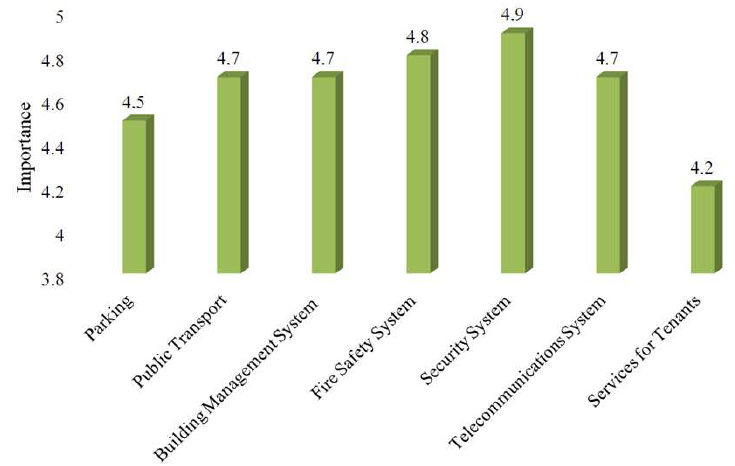
Fig. 5. Assessment of importance of retail and office center’s